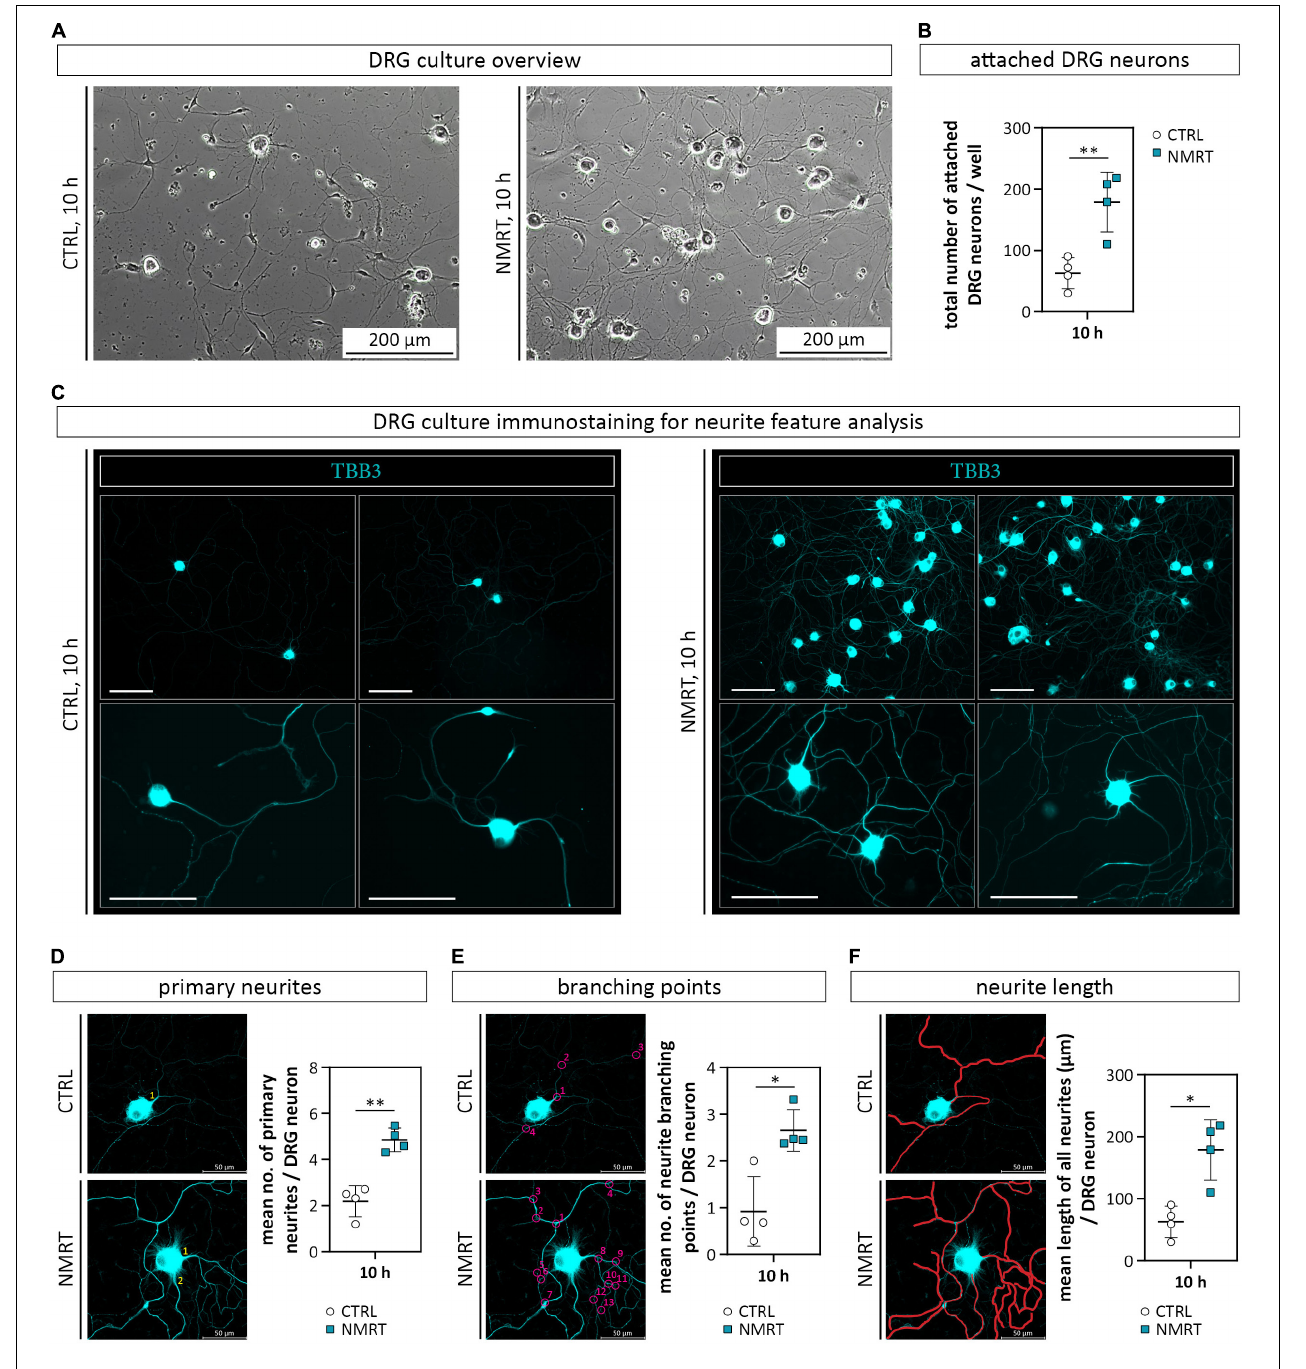
FIGURE 5 | Comparison of DRG cultures and neurite features in response to NMRT. (A) Representative phase contrast images illustrating the morphology of control DRG culture (left image) as well as NMRT treated DRG cultures (right image) after the 10 h treatment cycle. (B) Counting of the total number of attached DRG neurons per well showed a significant increase of DRG neurons in NMRT treated cultures; data are depicted as mean values for each donor ± SD ( n = 4), ** p < 0.01. (C) Representative immunofluorescence images of control DRG cultures (left panel) and NMRT treated DRG cultures (right panel) after the 10 h treatment cycle stained for early neuronal marker tubulin β -3 (TBB3, cyan). An enhanced neurite outgrowth of DRG neurons was observed upon NMRT treatment. Scale bars represent 100 µ m. Representative images of TBB3 stained neurons in CTRL and upon NMRT alongside with quantification of (D) the mean number of primary neurites per DRG neuron (primary neurites indicated by numbers), (E) the mean number of neurite branching points (indicated by numbered circles) per DRG neuron, and (F) the mean length of all neurites (indicated by manually drawn neurites in red) per DRG neuron between control and NMRT treated DRG cultures; data are depicted as single values for each donor ± SD ( n = 4), two-way ANOVA, ∗∗ p < 0.01, ∗ p < 0.05.